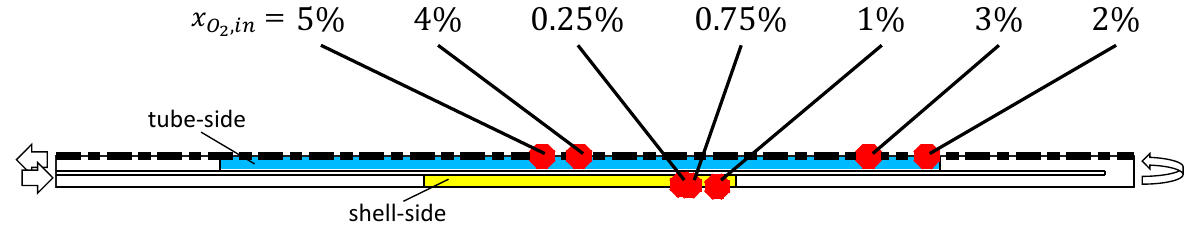
= 1%; x = O 2 , in = 1%; 3 H 8 , in = 1%; 3 H 8 ,in 3 H 8 ,in